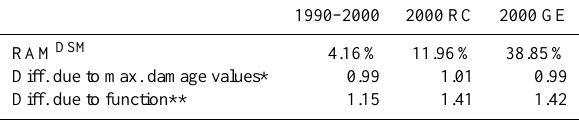
Table 4. Relative estimate of damage developments of the model- run RAM DSM and difference factors between relative estimates of the RAM and the RAM DSM , and between the RAM DSM and the